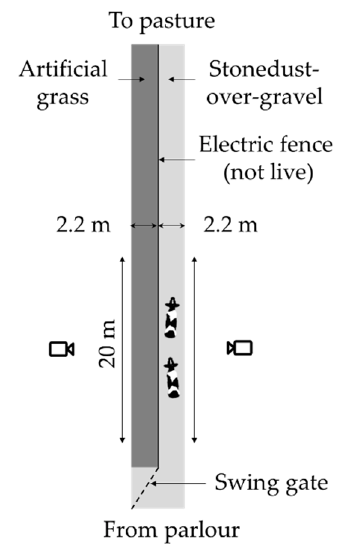
Figure 1. Setup used for the forced trial in which dairy cows’ gait pattern was analysed. The surface types were switched between the two replicates. Figure not to scale.